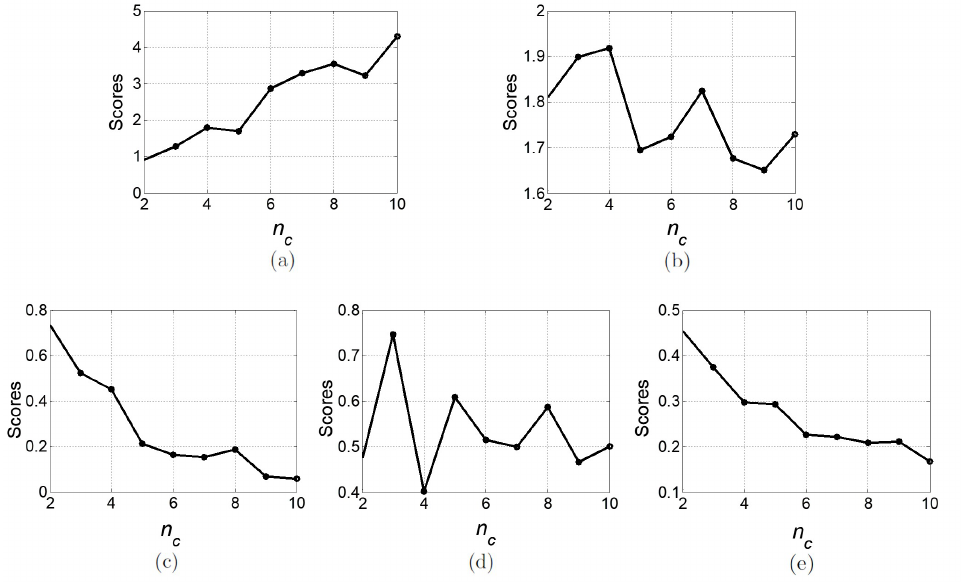
Figure 10. Evolution of CVIs for summer using the FCM algorithm for n c clusters indicated by: ( a ) XB ( ↓ ); ( b ) DB ( ↓ ); ( c ) DI ( ↑ ); ( d ) WI ( ↑ ); ( e ) Sil ( ↑